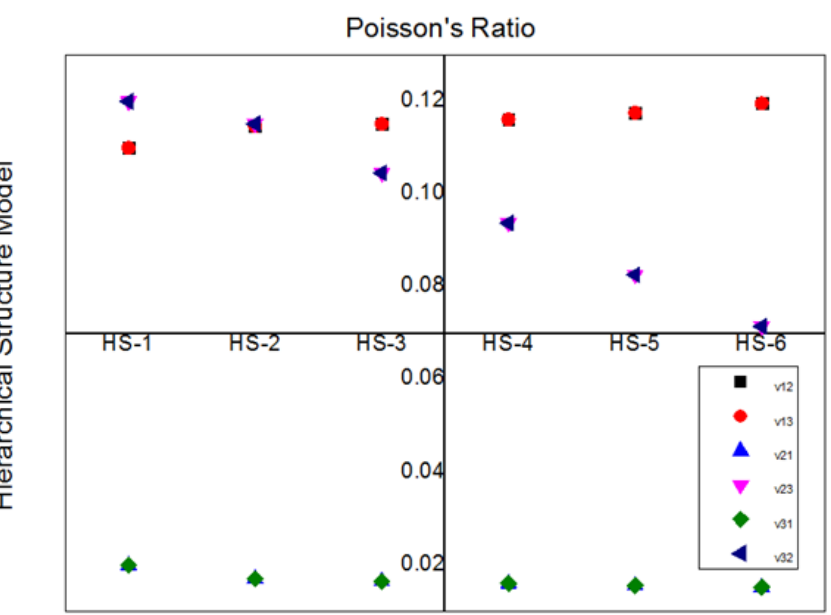
Figure 7. Poisson’s ratio for different Hierarchical Models.